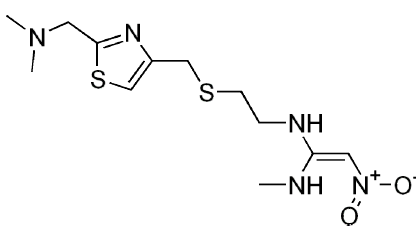
Figure 1. Structural formula of nizatidine.